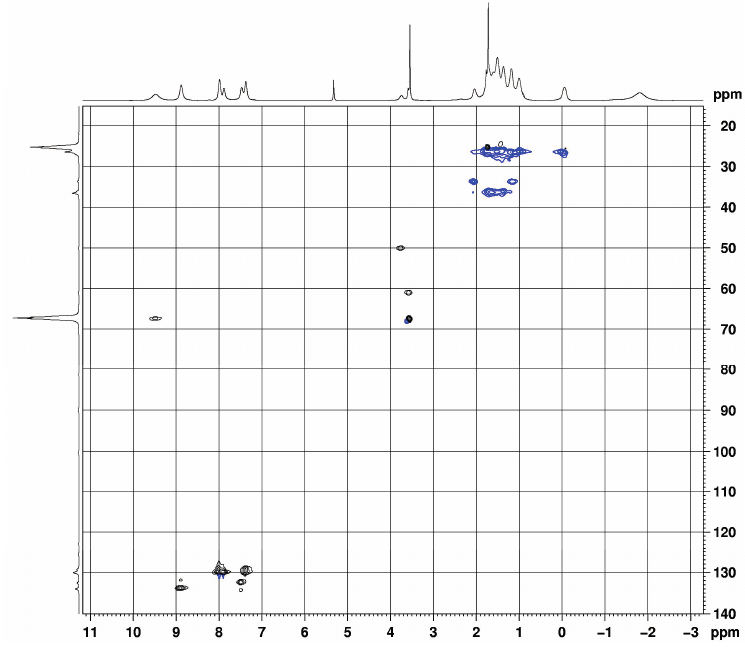
Figure 3. HSQC spectrum (400 MHz, THF- d 8 , 25 °C) of [Ph–C ≡ C–C(NCy) 2 ] 3 Ce ( 4